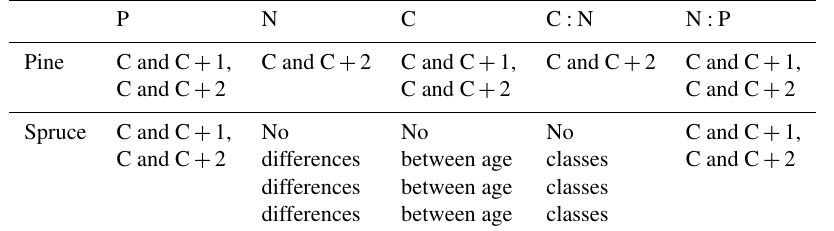
Table D1. Statistically significant differences between needle age group by species (C = youngest needles; C + 1 = 1-year-old nee- dles; C + 2 = 2-year-old needles) and p< 0 . 05 one-way analysis of variance, with Tukey’s honest significant difference post hoc test.